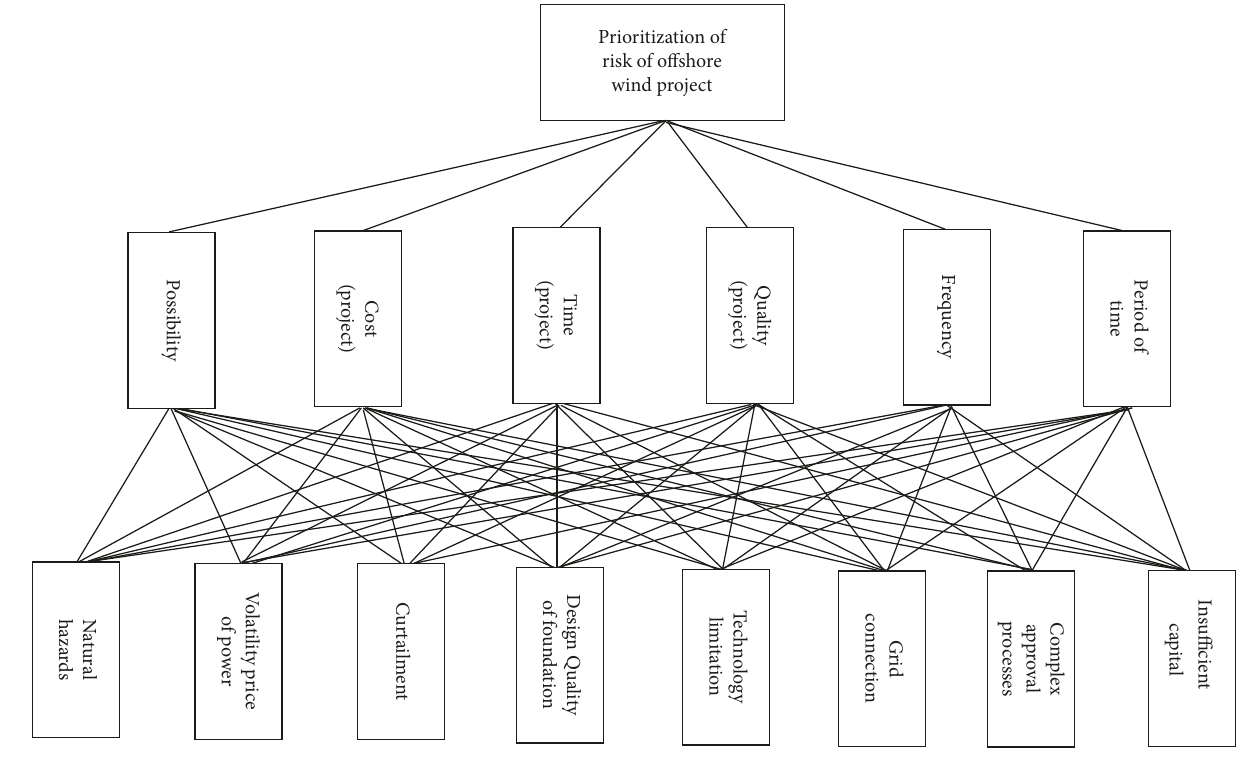
Figure 1: Framework for risk analysis in off-shore wind project.